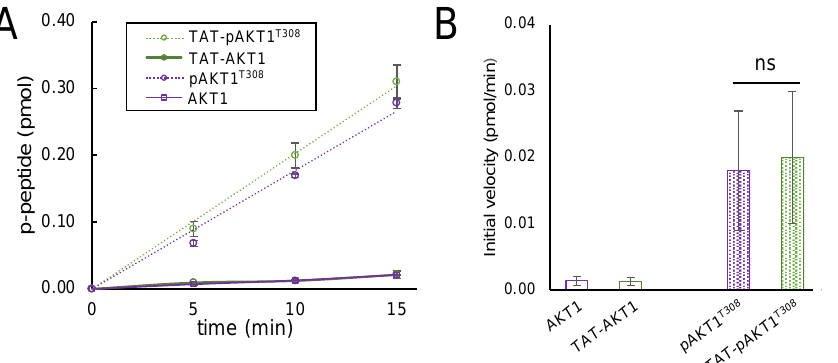
Figure 2. Enzymatic activity of AKT1 is dependent on phosphorylation at Thr308 and was not affected by fusion of AKT1 to the cell penetrating TAT-tag. ( A ) Time courses and ( B ) initial velocity of three independent in vitro kinase activity assays. AKT1 variants were incubated with a GSK-3 β substrate peptide and [γ - 32 P]- ATP and spotted on filter paper. Unreacted [γ - 32 P]-ATP was washed away and reaction products visualized by phosphorimaging (Figure S3) and quantified. AKT1 (purple) and TAT-AKT1 (green) did not show significant activity above background, whereas pAKT1 T308 (purple dotted) and TAT-pAKT1 T308 (green dotted) were enzymatically active. The TAT-tag did not significantly alter pAKT1 T308 activity. Significant differences were calculated by two-tailed t-test (ns – not significant).